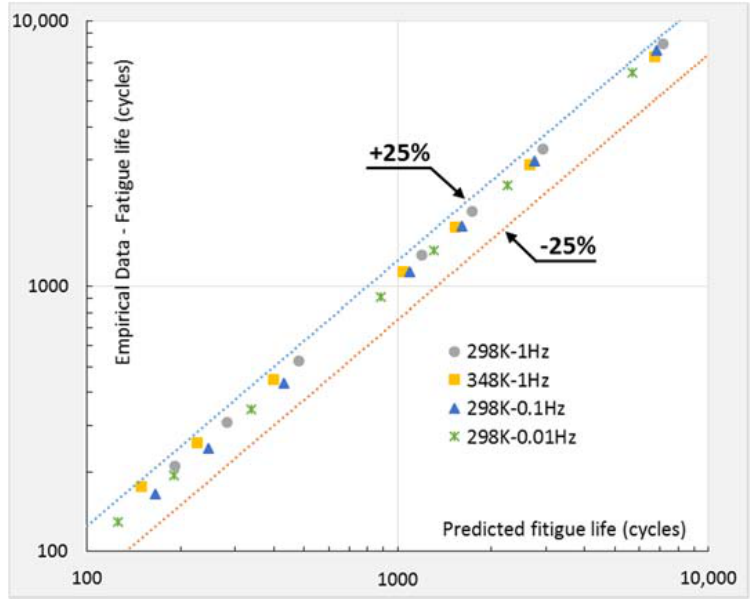
Figure 3. Prediction ratio for 63Sn37Pb solder.